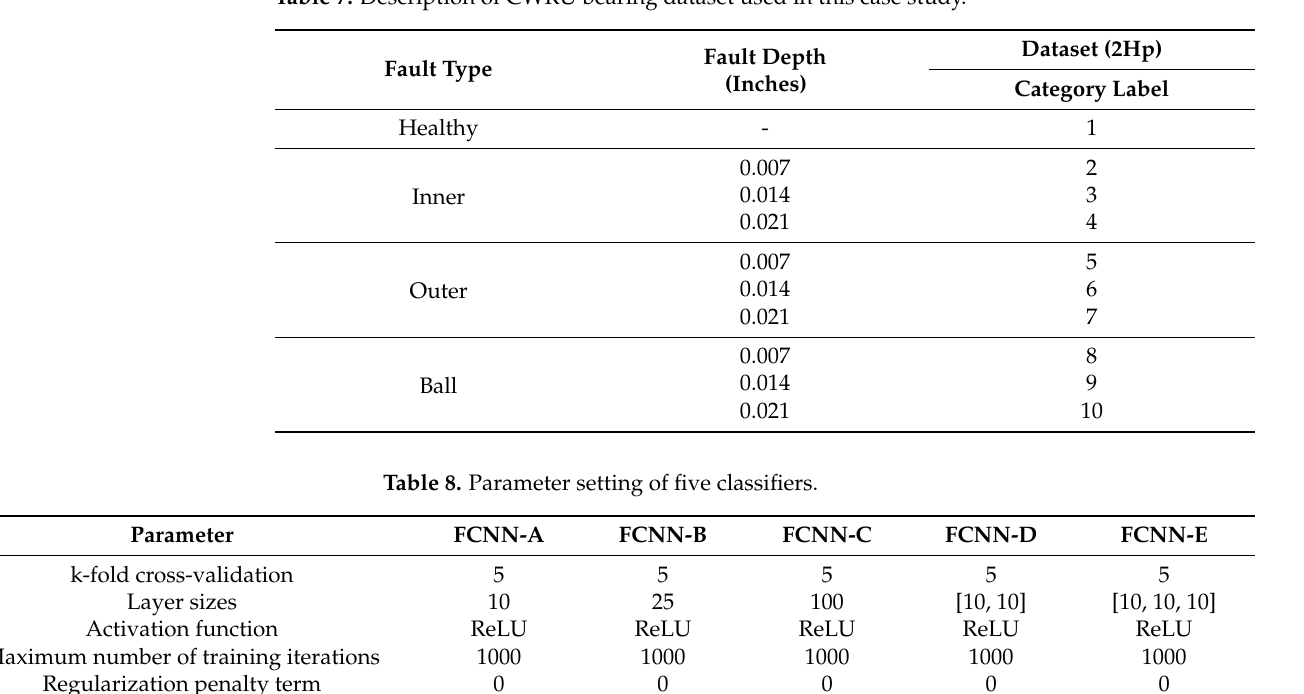
Table 7. Description of CWRU bearing dataset used in this case study.